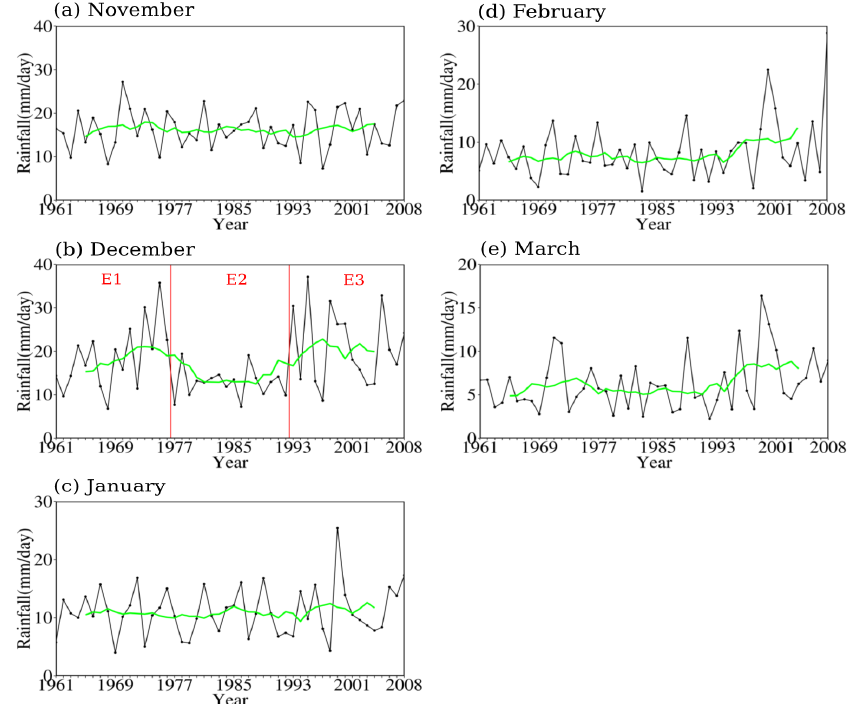
Figure 3. Time series of average monthly rainfall (mm day − 1 ) of climate Type II stations from 1961 to 2008 for ( a ) November; ( b ) December; ( c ) January; ( d ) February; and ( e ) March. The red vertical lines in ( b ) indicate the significant change points around 1976/1977 and 1992/1993 that divides the time series into three epochs: E1 (1961–1976); E2 (1977–1992); and E3 (1993–2008). The green line indicates the 9-year running average.